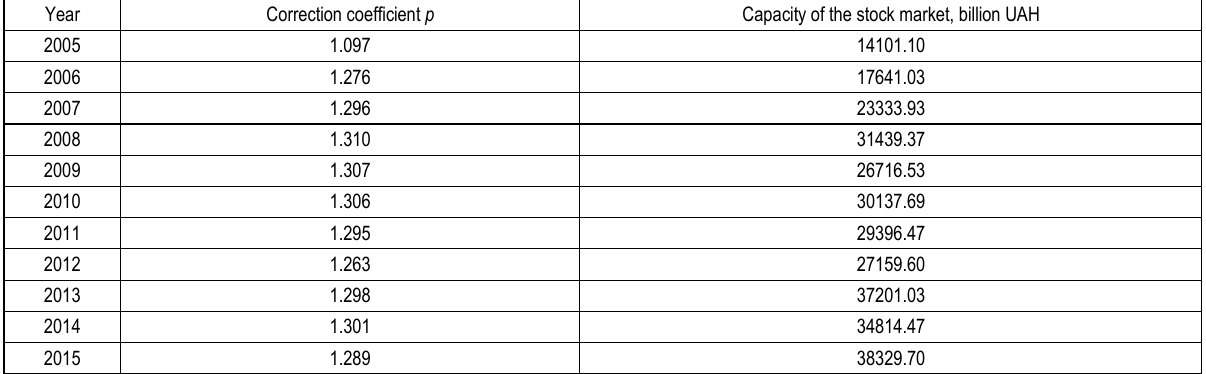
Table В .4. The results of calculations of the correction coefficient and the capacity of the Ukrainian insurance market for the period 2005 – 2015